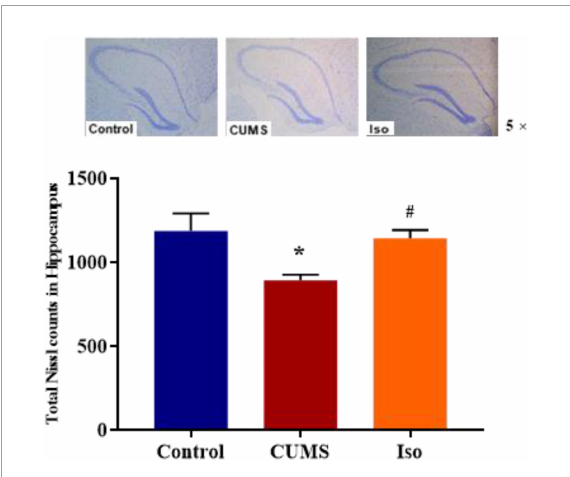
FIGURE5 Effects of isorhynchophylline on Nissl staining in hippocampus. The data are presented as mean ± SEM. * P < 0.05 compared to the Con group; # P < 0.05 compared to the CUMS group.